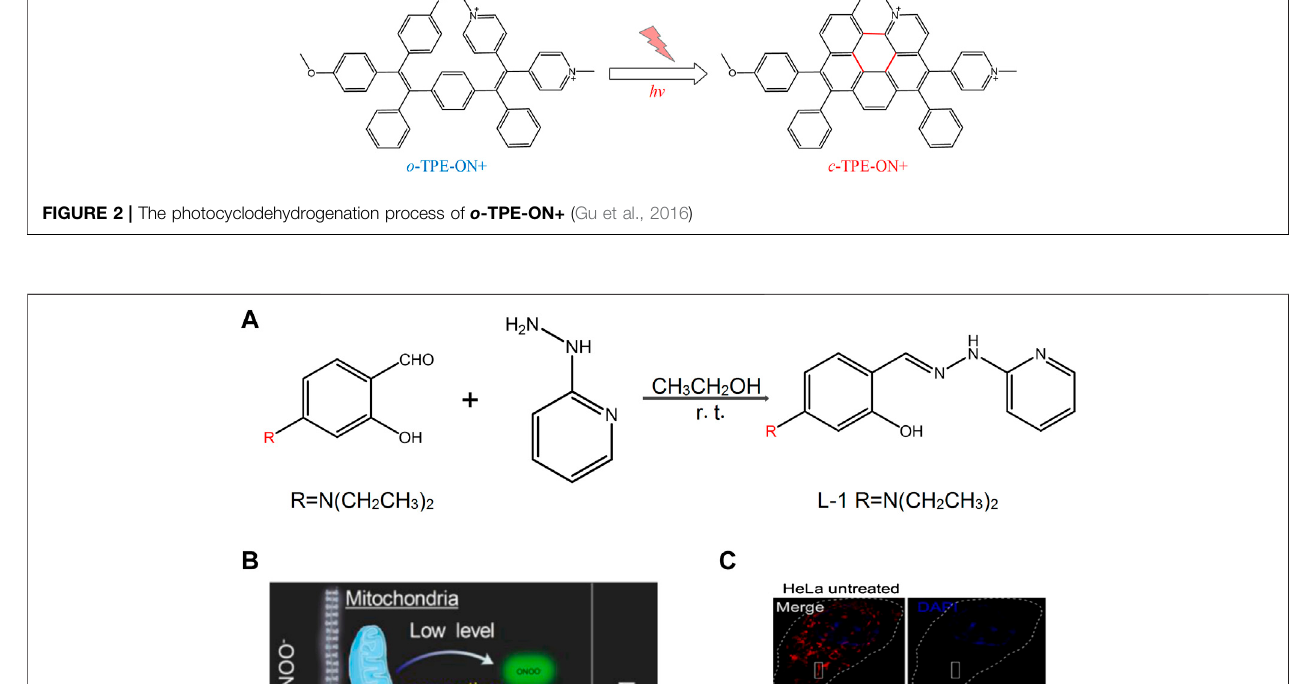
Frontiers in Pharmacology |